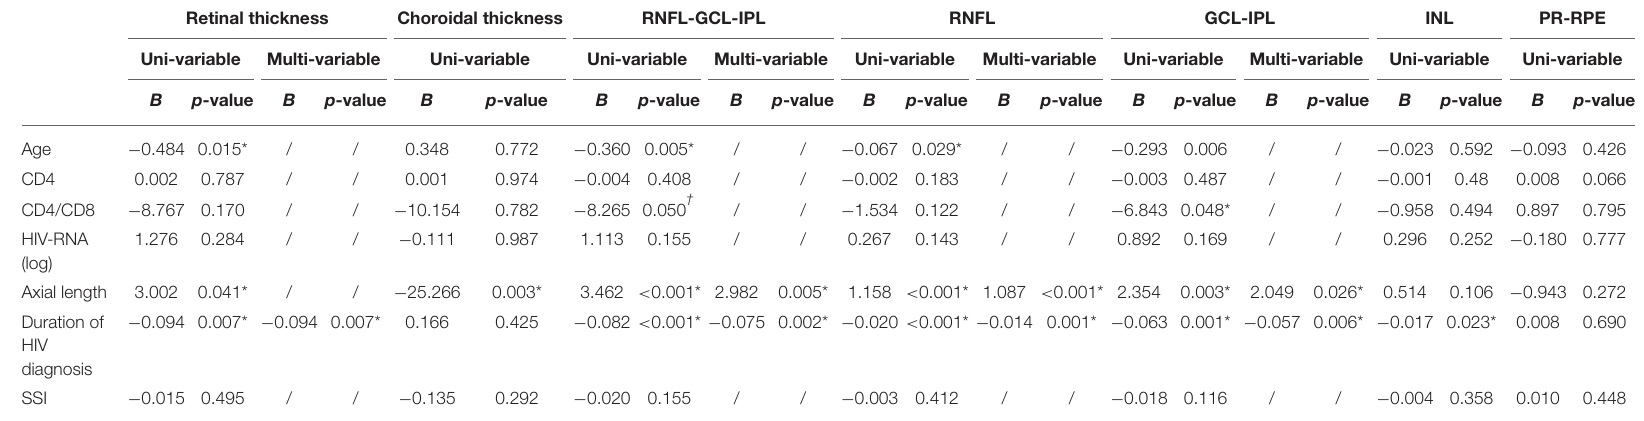
TABLE 3 | Multivariable linear regression analysis between macular structural parameters in the entire Early Treatment of Diabetic Retinopathy Study grid and systemic variables in all patients with human immunodeficiency virus infection (model one).